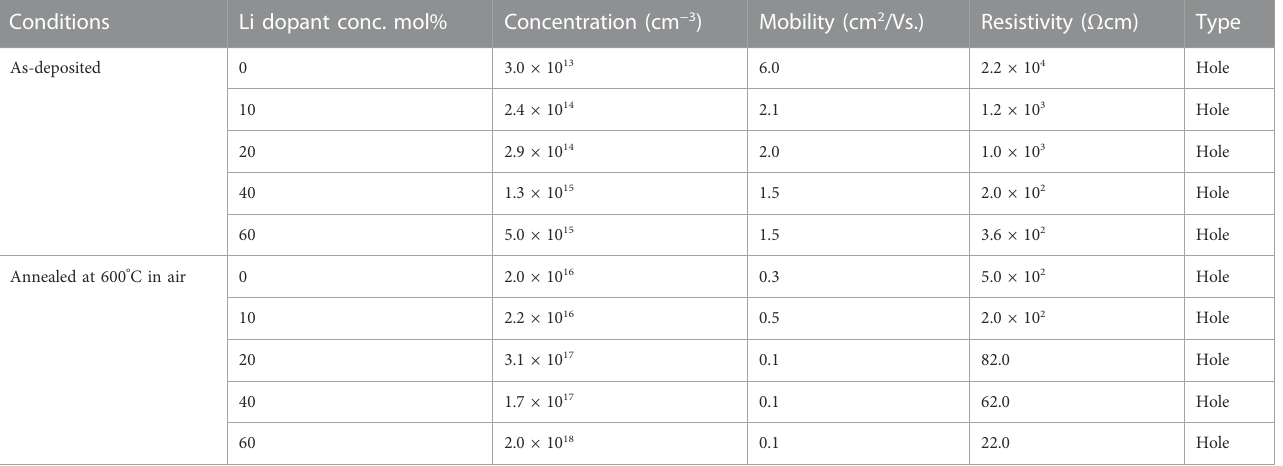
TABLE 3 Carrier concentration, mobility, and resistivity of the as-deposited at 400 ° C and 600 ° C annealed Li:NiO x thin fi lms as a function of Li amount in the precursor solution. Conditions Li dopant conc. mol%